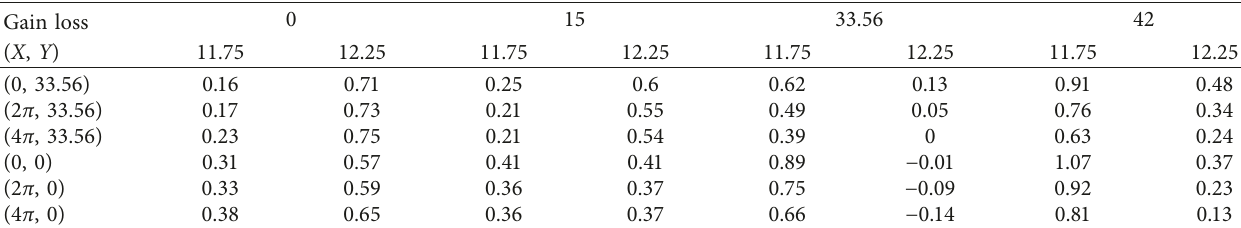
Figure 7: S parameters of each subarray. Rotation angles of (a) 0 ° , (b) 15 ° , (c) 33.56 ° , and (d) 42 ° . Table 1: Gain losses for different rotation angles and time compensations.